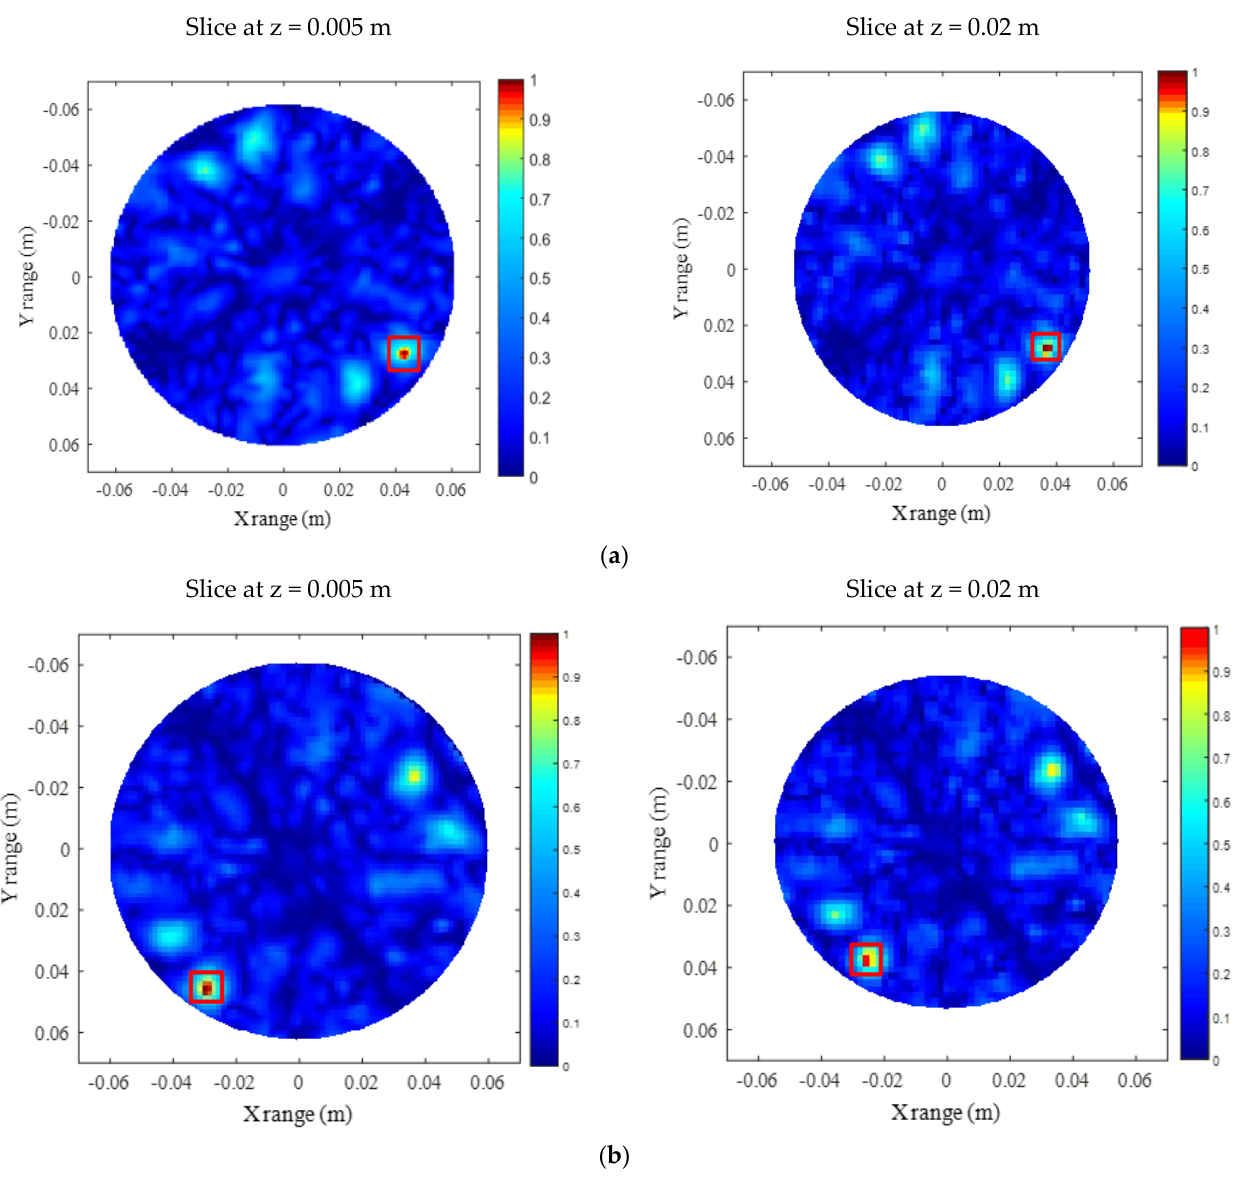
Figure 11. Reconstructed images of the tumorous breast phantom at ( a ) position A and ( b ) position B. Slice depth (z) is from the chest